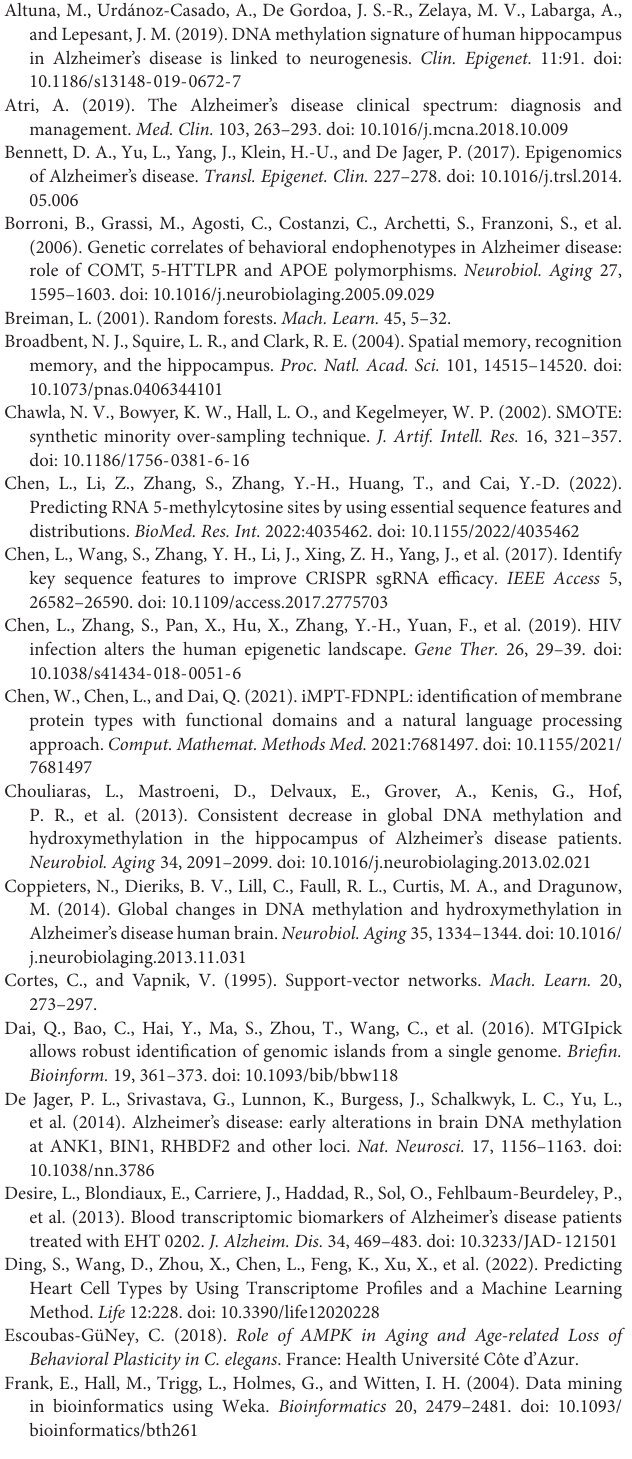
Supplementary Table 2 | Performance of IFS for CRB brain structure. Supplementary Table 3 | Performance of IFS for ERC brain structure.